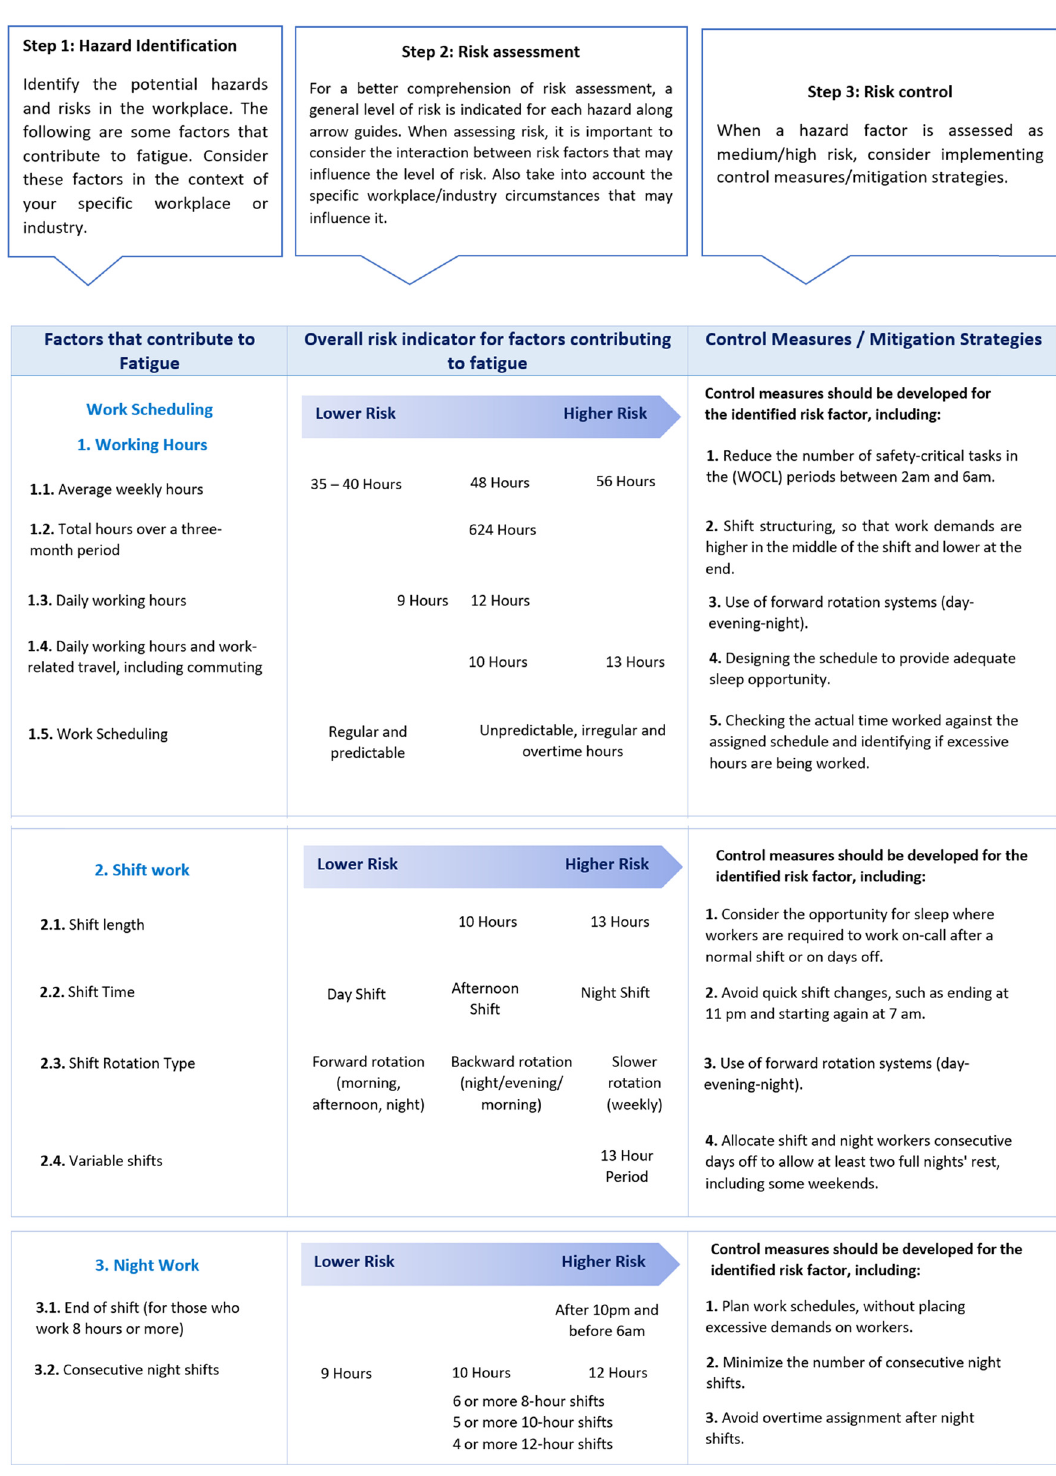
Figure 2: Fatigue risk management map for ramp workers. Source: own elaboration, based on previous studies [ 35,41,42 ]